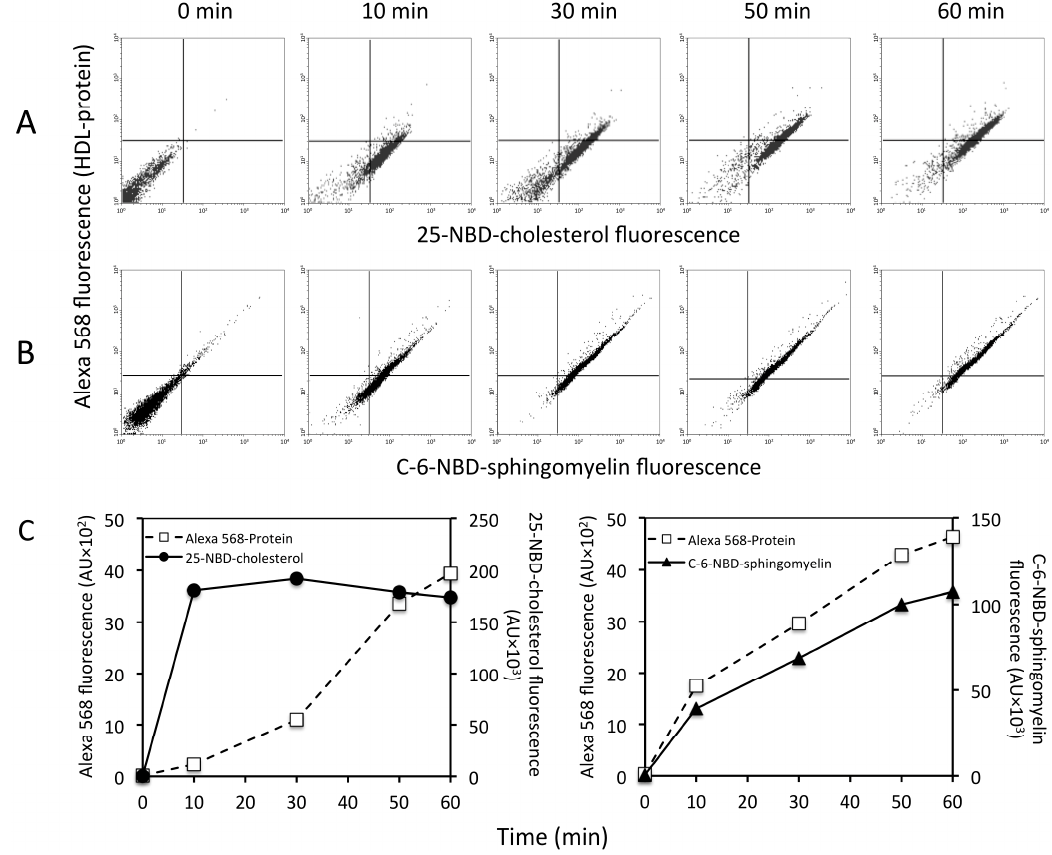
Figure 2. Kinetics of internalization assays performed by flow cytometry using double-labeled rHDL. HMEC-1 was incubated from 10 to 60 min with rHDL containing either ( A ) 25-NBD-cholesterol and HDL protein labeled with Alexa 568 or ( B ) C-6-NBD-sphingomyelin and HDL protein labeled with Alexa 568 fluorescent tracers. Cholesterol was rapidly associated with the cells from 10-min incubation with rHDL (right lower quadrants in the dot plots of row A ), whereas protein began to be incorporated to HMEC-1 after 30 min of incubation (right upper quadrants). In contrast, both sphingomyelin and protein fluorescent signals were found associated with cells simultaneously (right upper quadrants in the dot plots of row ( B ). ( C ) The 60-min internalization kinetics of the 25-NBD-cholesterol and HDL protein labeled with Alexa 568 (Alexa 568 Protein) ( left ) and C-6-NBD-sphingomyelin and apo AI-Alexa 568 ( right ). Results are the mean of three independent experiments for each tested time.